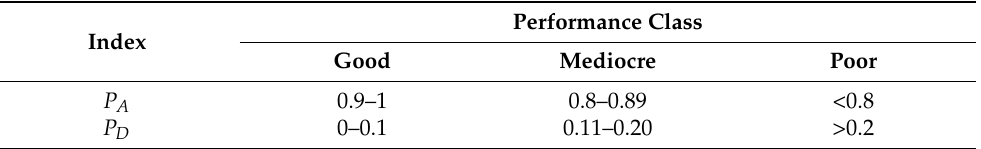
Table 1. Molden and Gates’ standard for adequacy and dependability